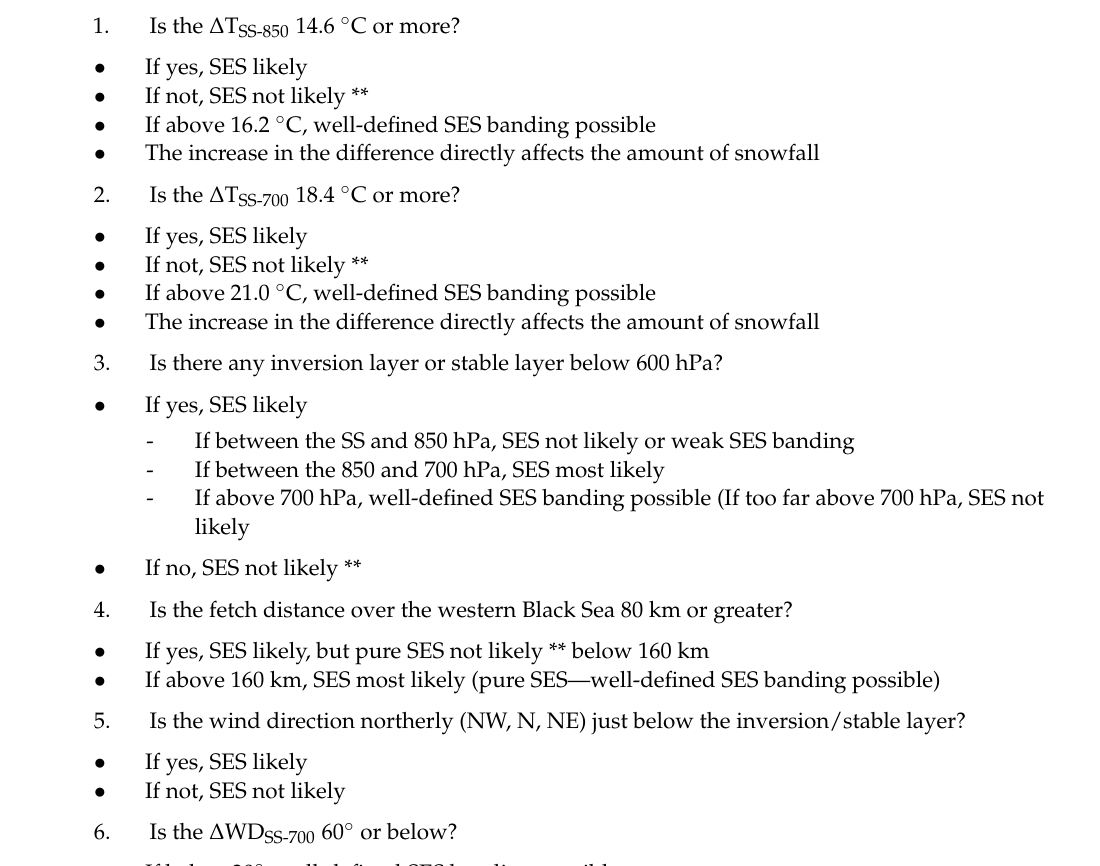
Algorithm 1. For the SES prediction at LTBA and LTBJ (in